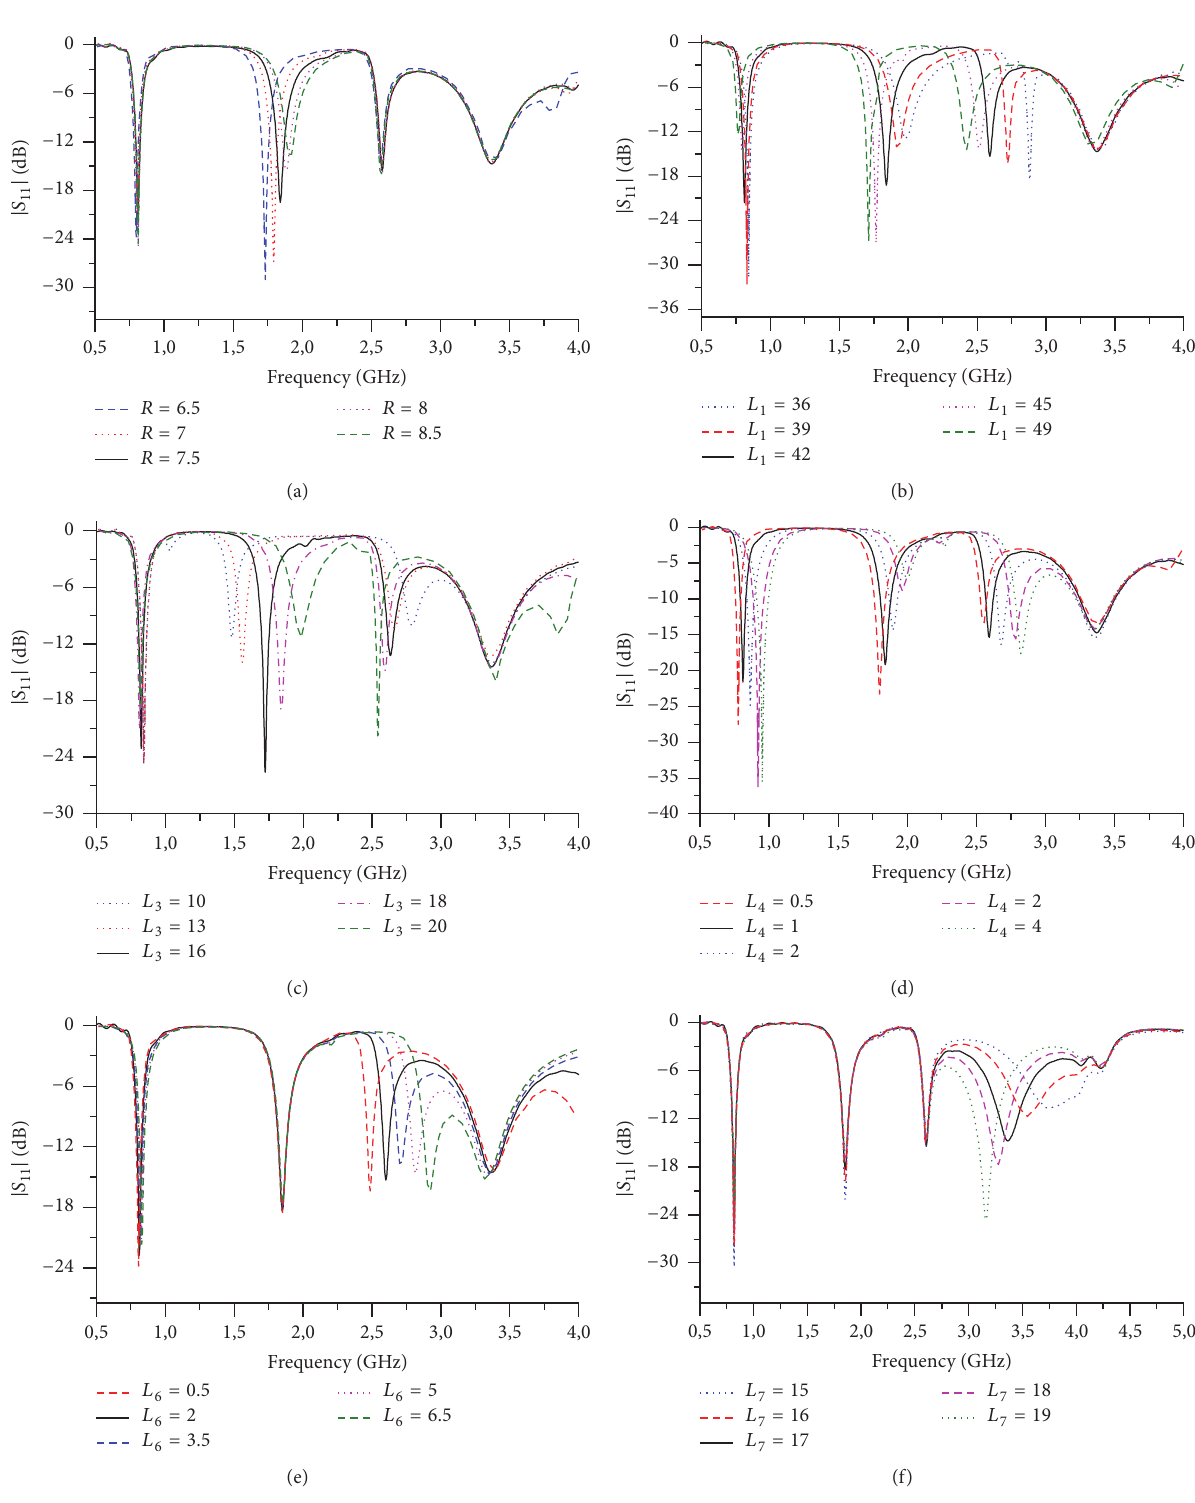
Figure 4: Simulated reflection coefficient as a function of (a) the parameter 𝑅 , (b) the parameter 𝐿 1 , (c) the parameter 𝐿 3 , (d) the parameter 𝐿 𝐿 𝐿 4 , (e) the parameter 6 , and (f) the parameter 7